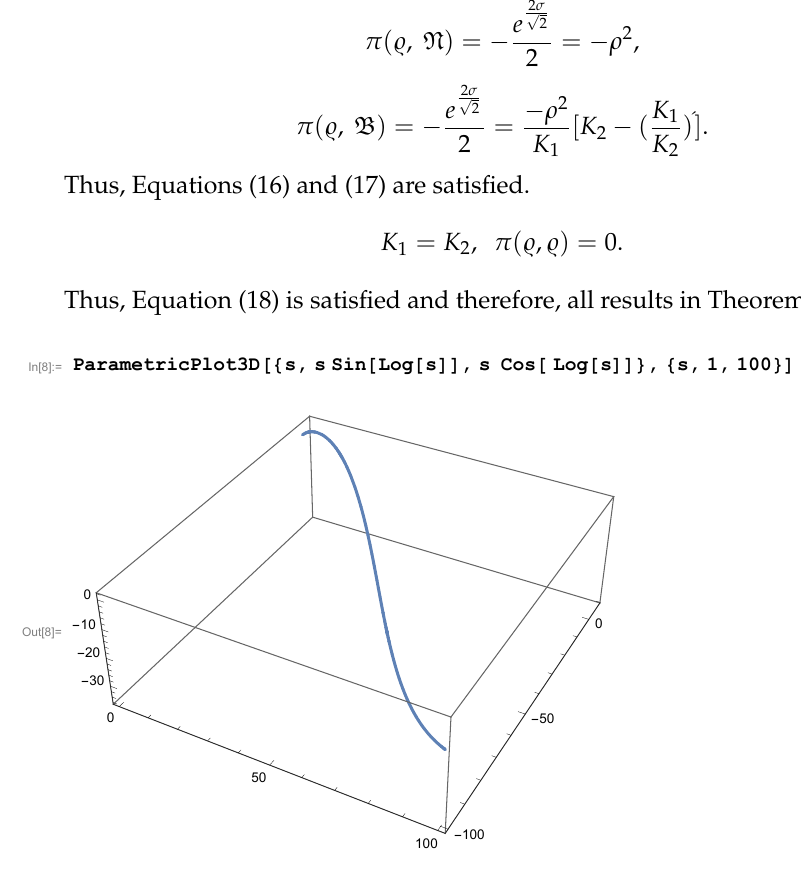
Figure 1. An EQS curve with an EQS normal satisfying the